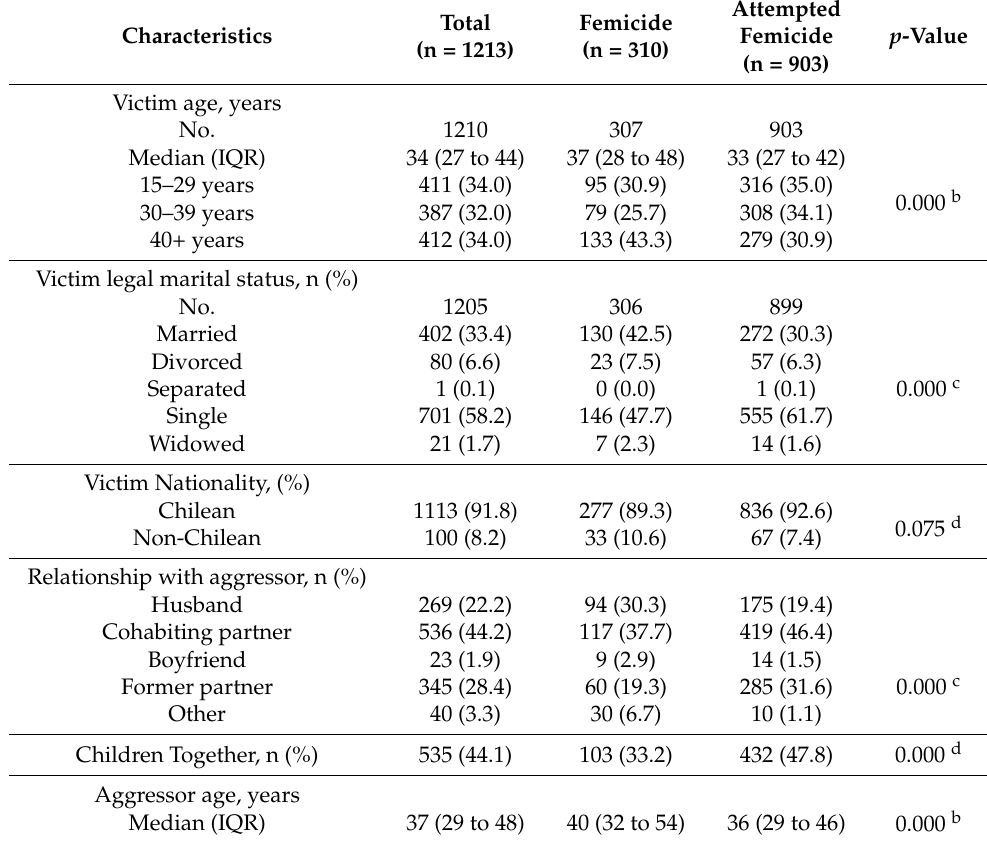
Table 2. Characteristics of the event, victim, and aggressor between the attempted femicide and femicide